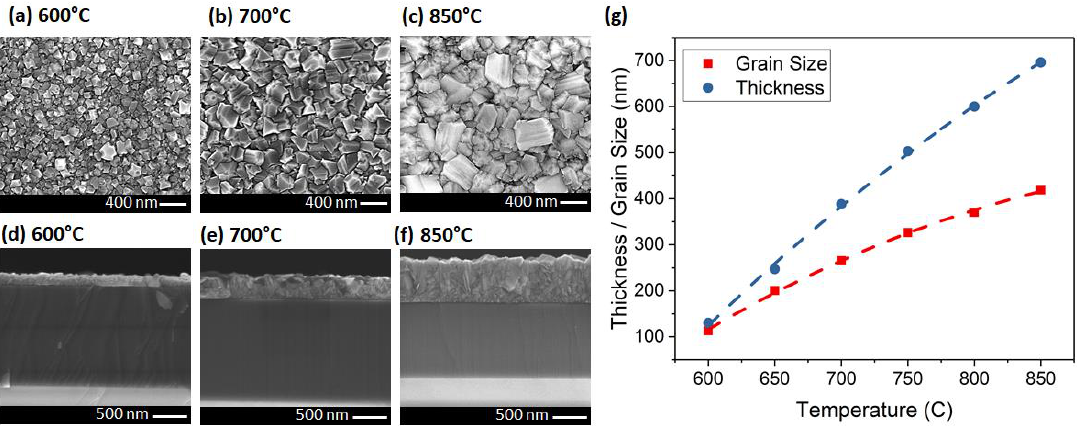
Figure 4. Plan- and cross-sectional-view SEMs of the diamond layer at ( a, e ) 600, ( b, f ) 700, ( c, g ) 800, ( g ) The relationship between thickness / grain size and the temperature (lines are guides to the eye and ( d, h ) 850 °C. ( i ) The relationship between thickness/grain size and the temperature (lines are guides to the eye only).